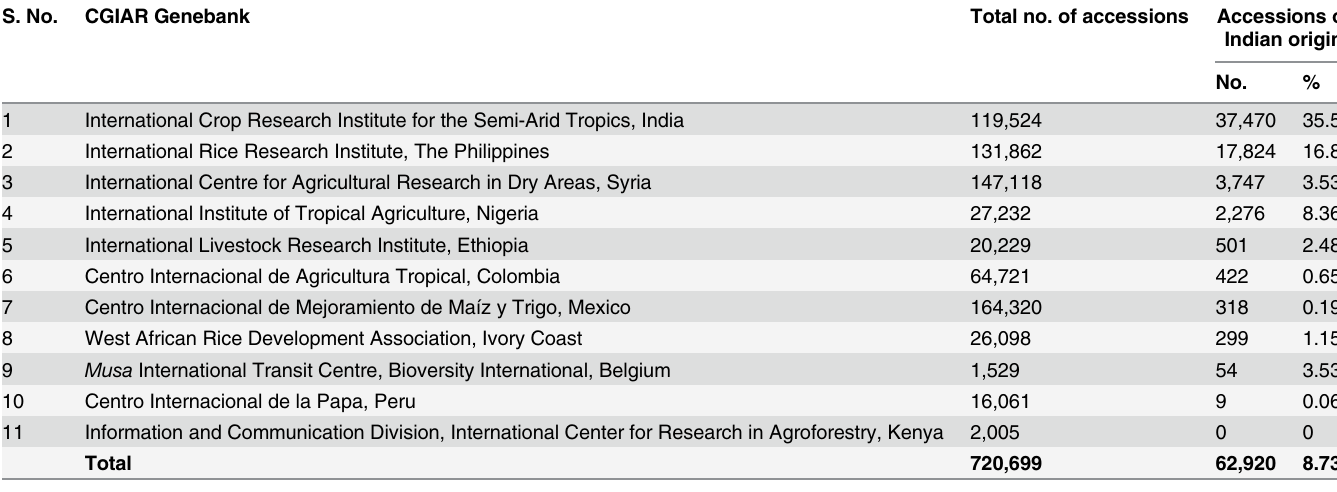
The table lists the number of accessions of Indian-origin, conserved in the 11 CG genebanks. The genebanks are listed by ‘ No. of accessions of Indian origin ’ in descending order.